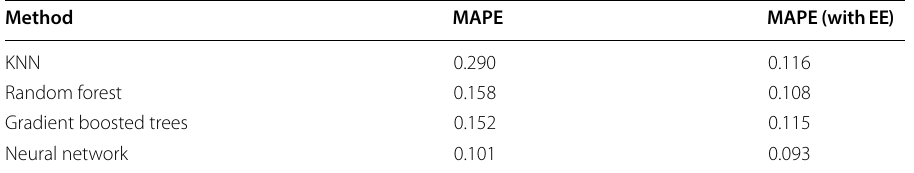
Table 7 Results copied from Guo and Berkhahn [3], MAPE is mean absolute percentage error, EE is entity embedding KNN is K-Nearest Neighbors, in all cases using entity embedding for encoding gives lower error, transfer learning employed for all models except neural network where direct learning is